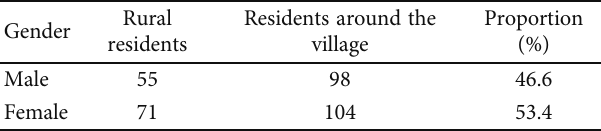
Table 3: Proportion of educational background.